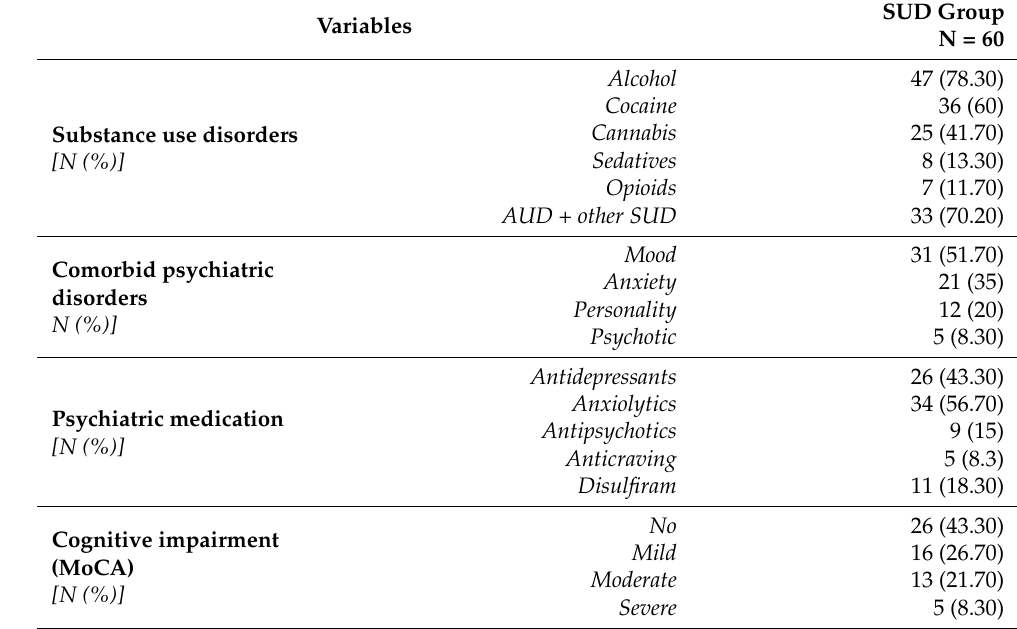
Table 2. Clinical characteristics of the SUD